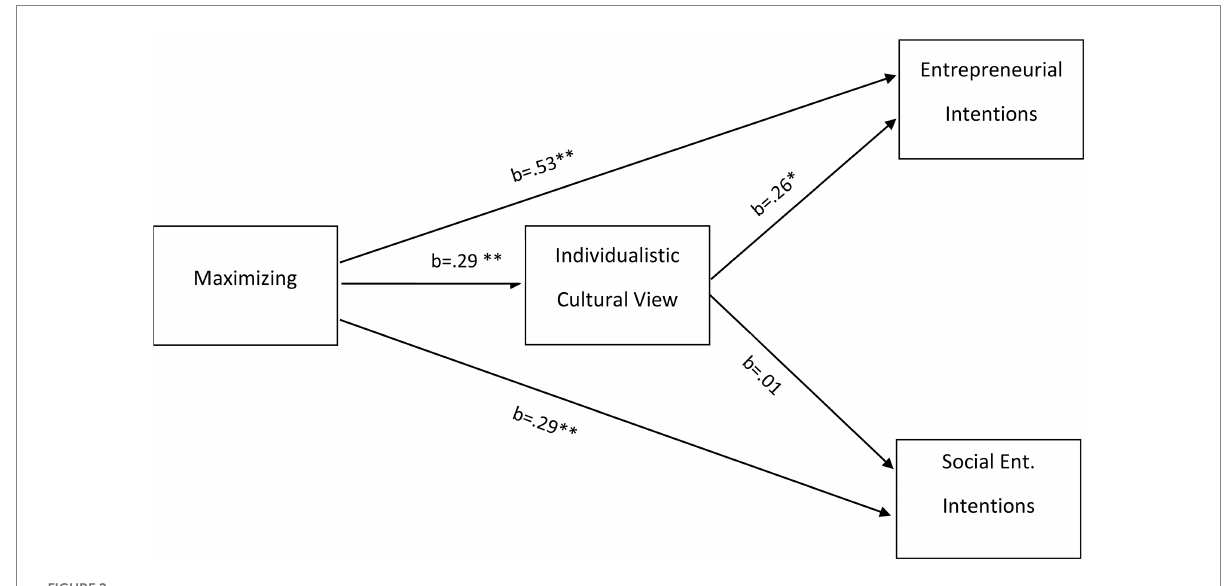
FIGURE 2 Mediation model. * p < .05; ** p <